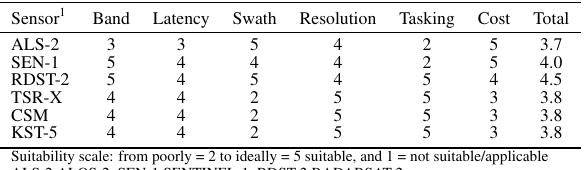
Figure 3. SAR Radarsat-2 image footprints over a one-week period covering the EEZ along South African coastline.